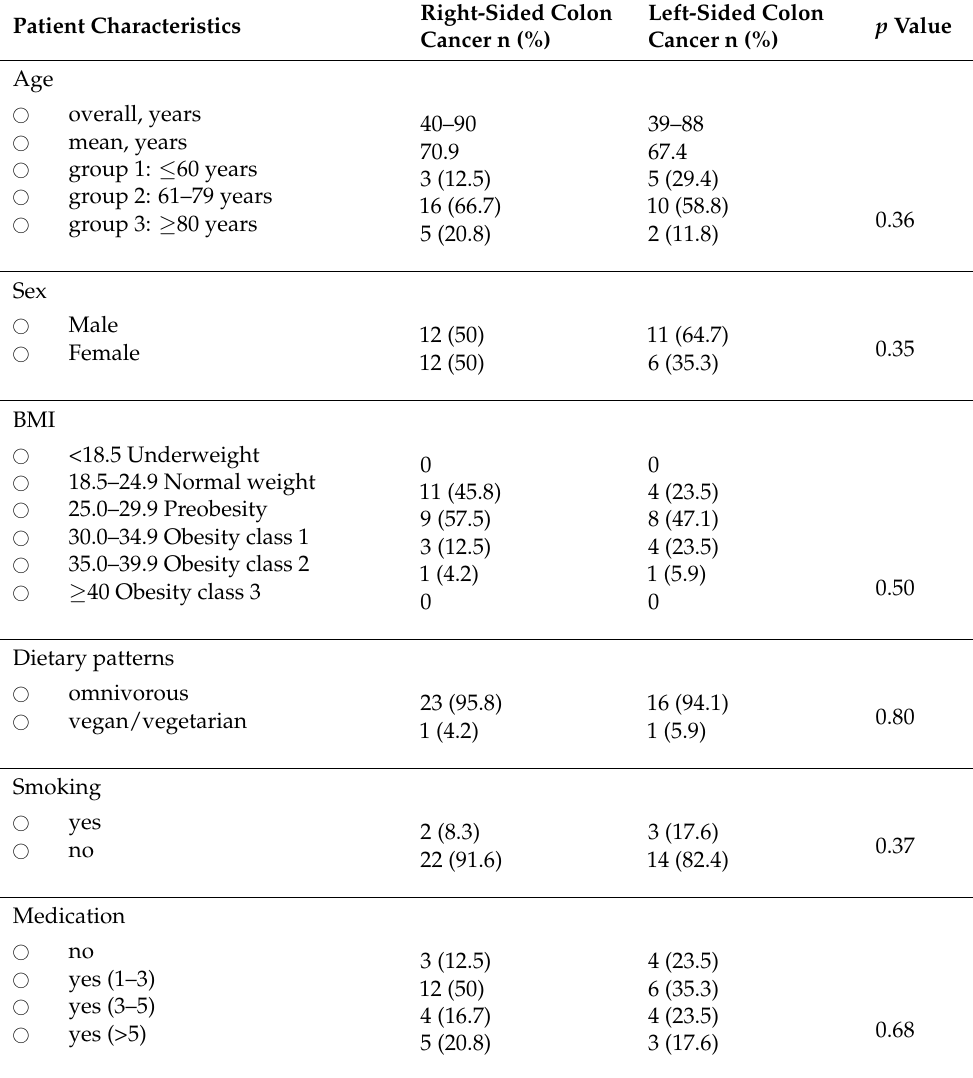
Table 1. Clinicopathological characteristics of the study